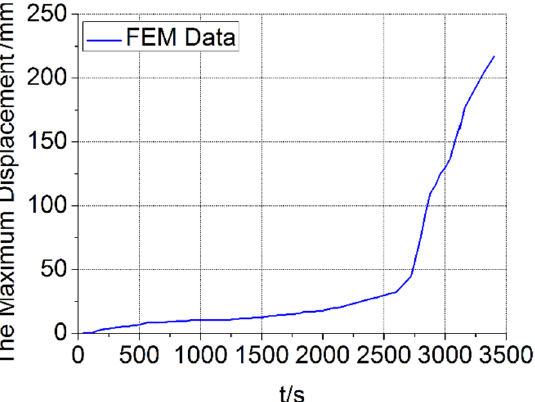
Figure 18. The maximum displacement of the middle position of the beam versus time.